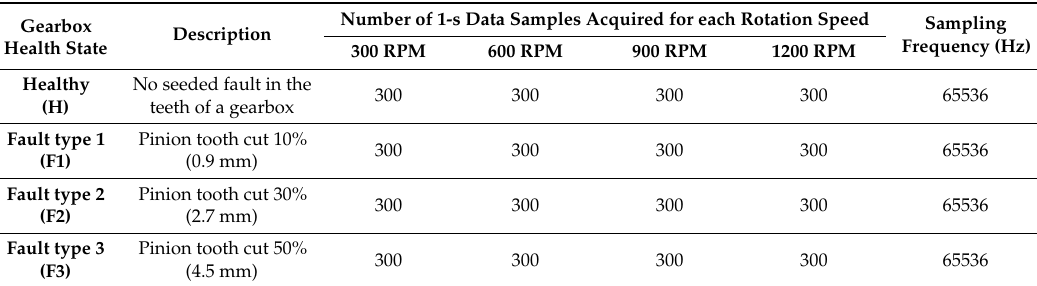
Figure 4. The health states of the gear wheel and examples of vibration signals at the rotation speed of 300 RPM: ( a ) no seeded fault, healthy gear, ( b ) tooth cut 10% (0.9 mm), ( c ) tooth cut 30% (2.7 mm), ( d ) tooth cut 50% (4.5 mm). Table 2. A detailed description of the fault types and dataset.